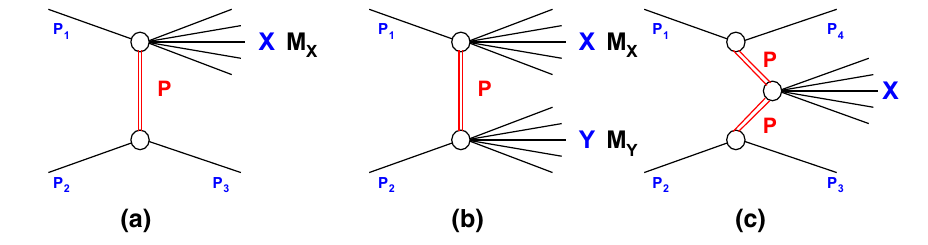
Fig. 1 Illustration of a single diffraction, b double diffraction, and c central diffraction with the pomeron exchanged in a proton–proton collision. M X and M Y are the invariant masses of the dissociated systems X and